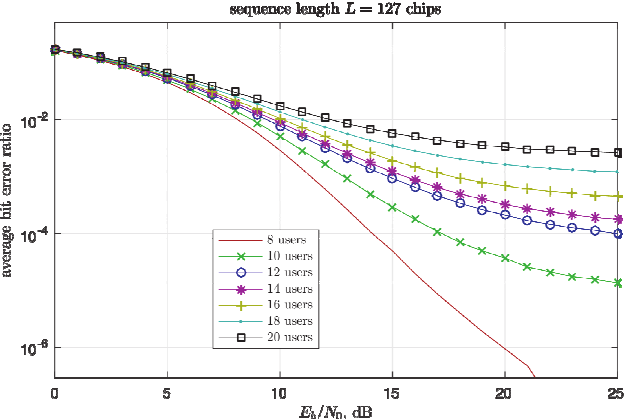
Fig. 9. Asynchronous DS-CDMA: BER performance in case of 127-chip-long chaotic spreading sequence.